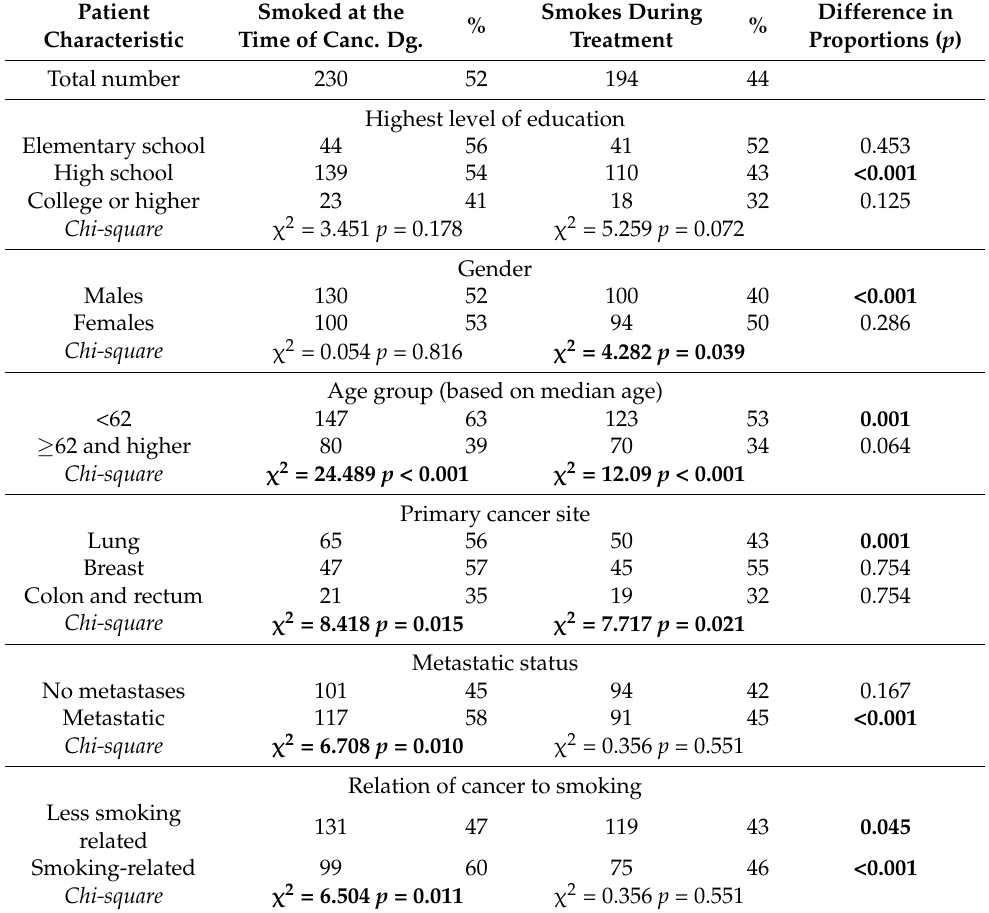
Table 2. Further analysis of the characteristics of the patients who admitted to smoking at any period ( N =